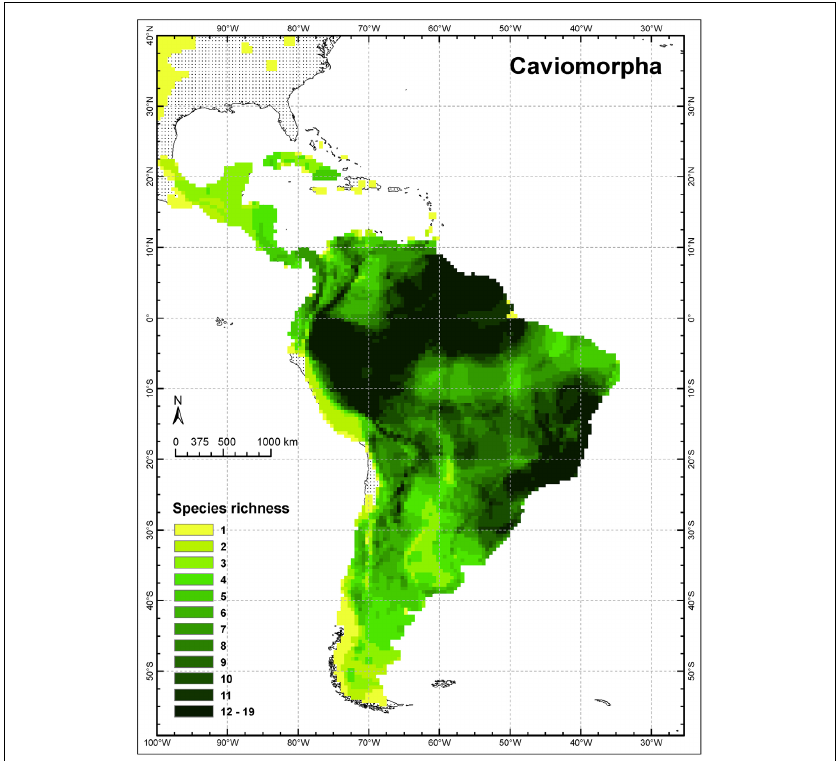
FIGURE 1 | Species richness of caviomorph rodents in the New World tropics (modified from Upham and Patterson, in